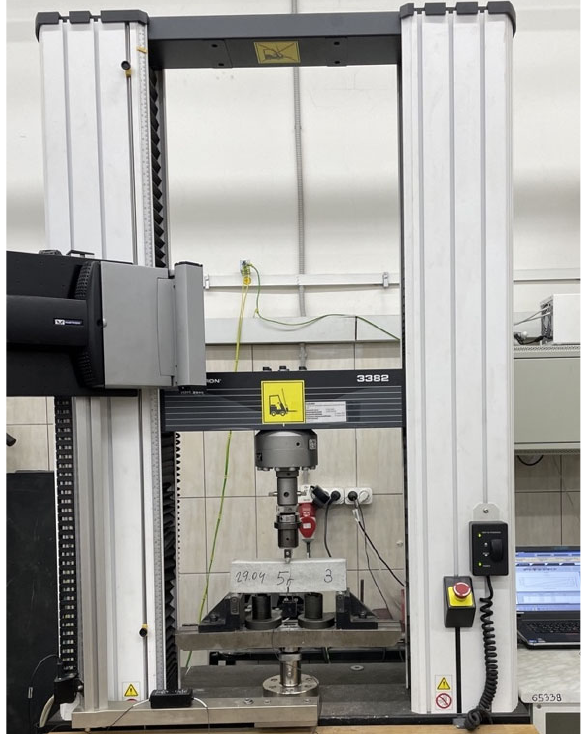
Figure 11. Testing of the samples in accordance with GOST 24452 ‐ 80.